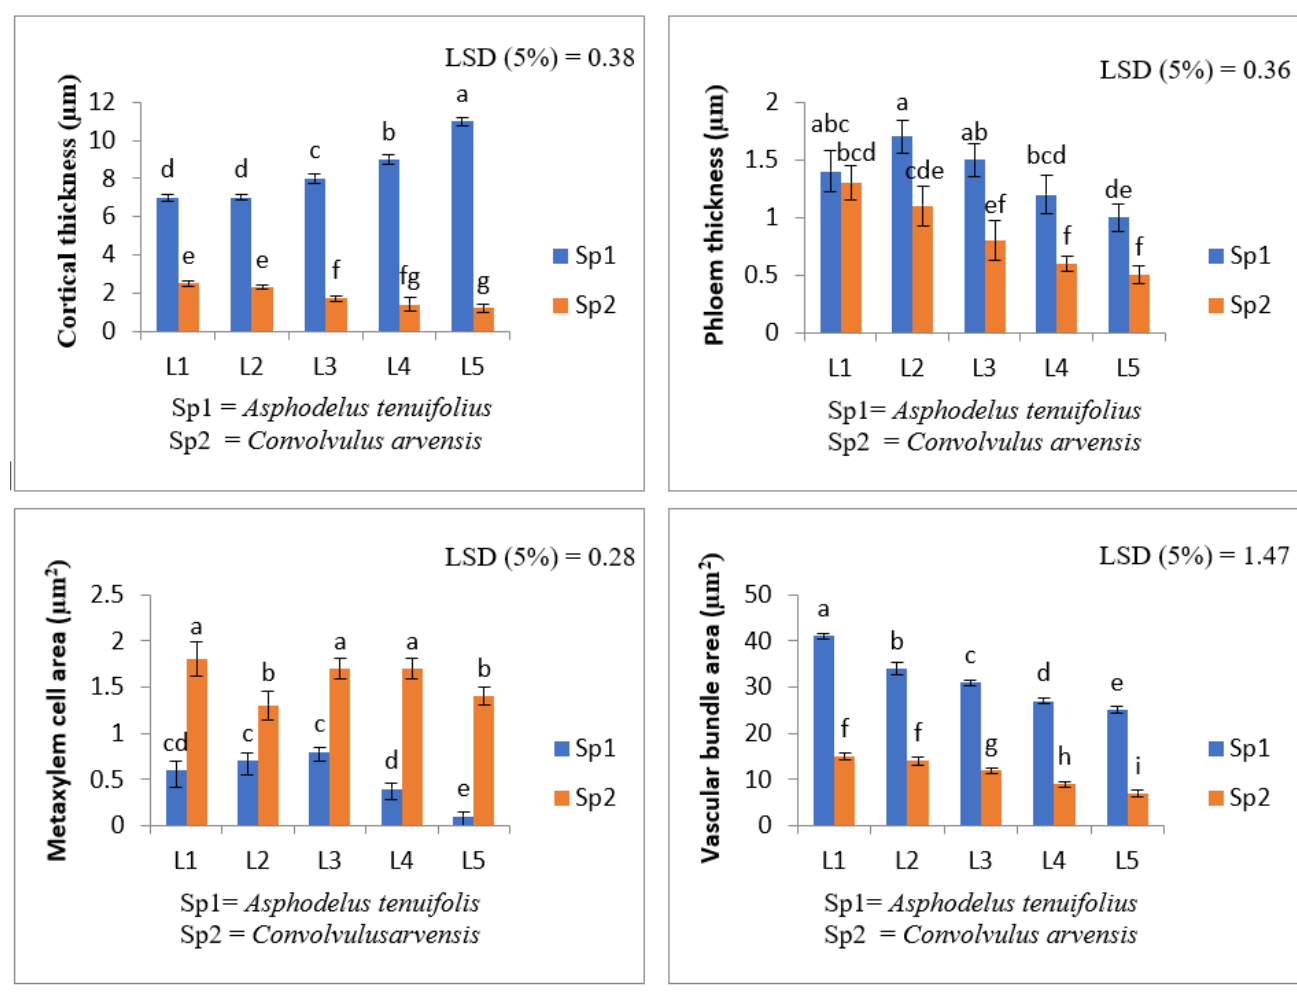
Figure 1. Effect of shoot extract of T. portulacastrum and herbicide on root anatomical parameters of A. tenuifolius and C. arvensis. L1 = distilled water; L2 = 30%; L3 = 60%; L4 = 100% and L5 = herbicide treatment. Means followed by the same letter did not significantly differ at p ≤ 0.05 according to LSD test.